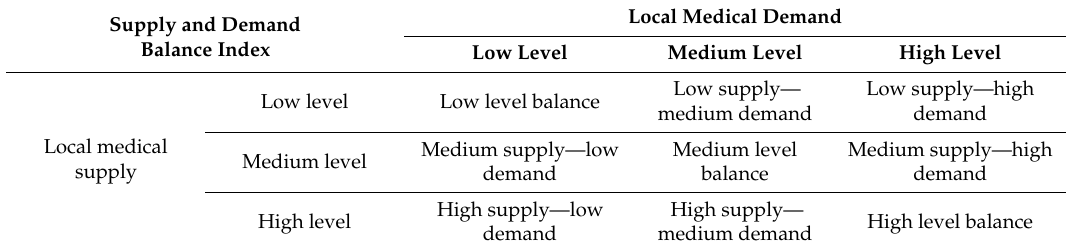
Table 5. Nine classifications for the medical supply and demand balance at the block